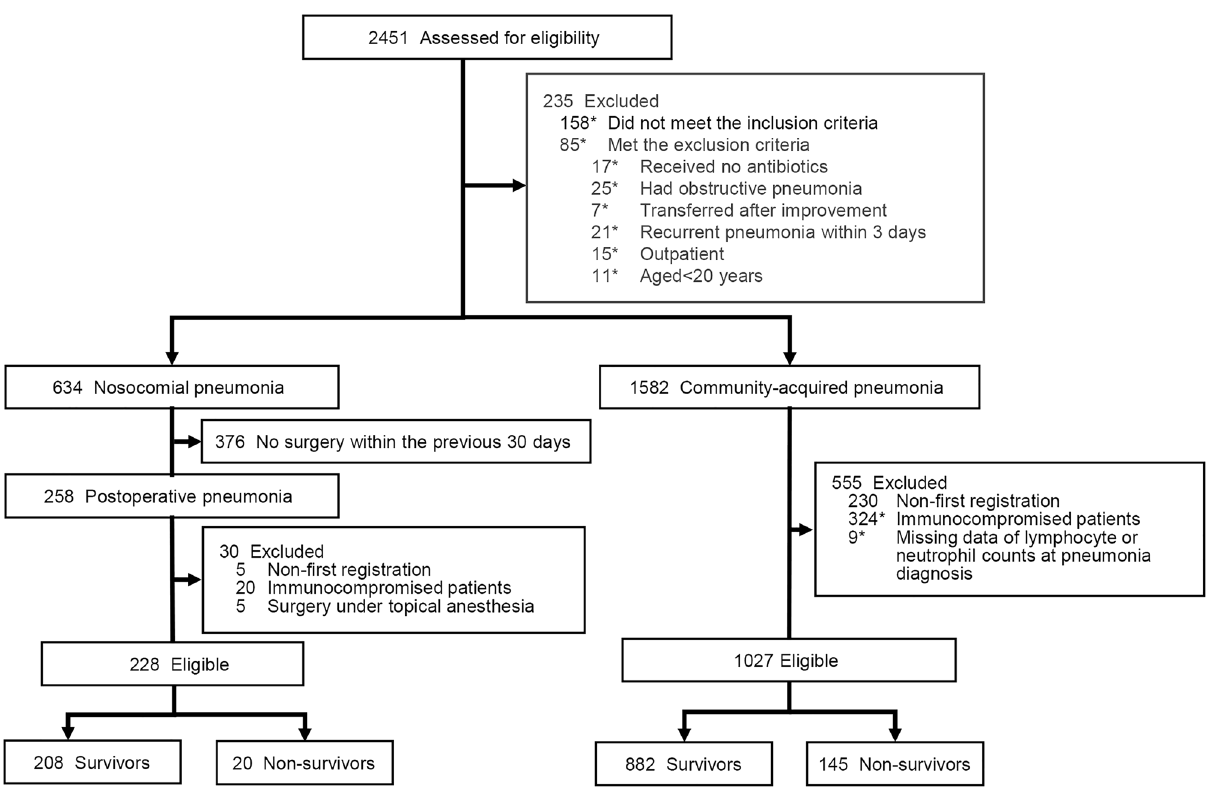
Figure 1. Patient flow. *Included overlapping